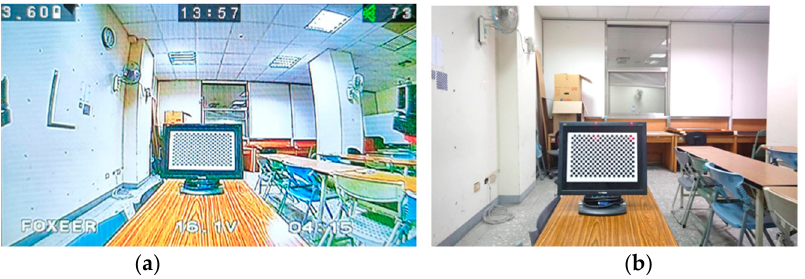
Figure 3. Camera’s field of view and lens distortion. ( a ) original UAV camera image ( b ) inspection camera image. Table 1. Specifications of original UAV and inspection cameras.